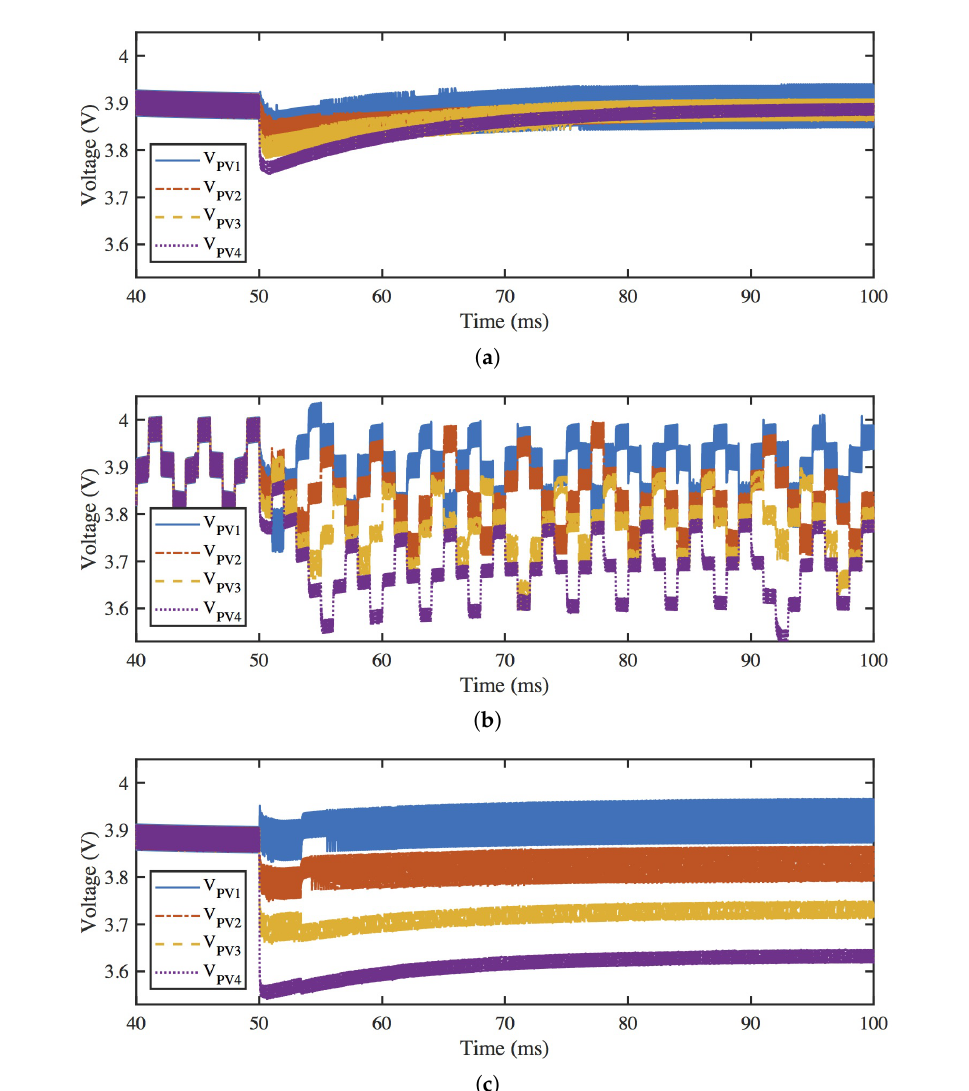
Figure 12. PV voltage waveforms for ( a ) constant voltage control, ( b ) perturb and observe control (P&O), and ( c ) voltage-offset resistive control